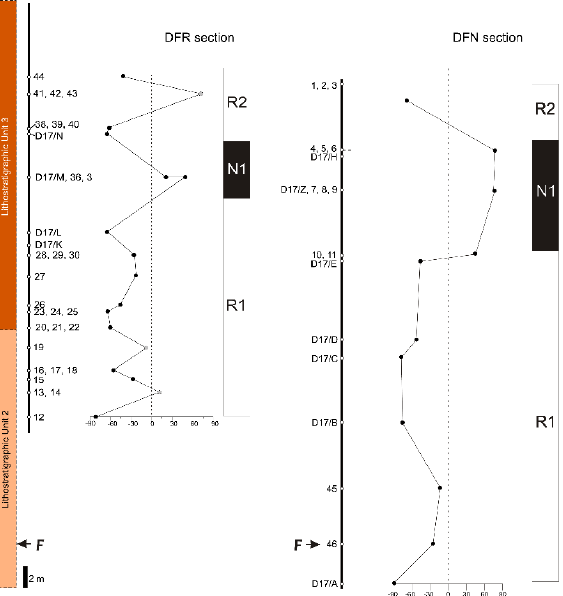
Figure 6. Magnetostratigraphy of the Dafnero sections. Normal and reversed polarities are represented by positive and negative VGP latitudes, respectively. Black dots represent reliable directions used for the magnetostratigraphy while grey dots mark discarded unsuitable samples.